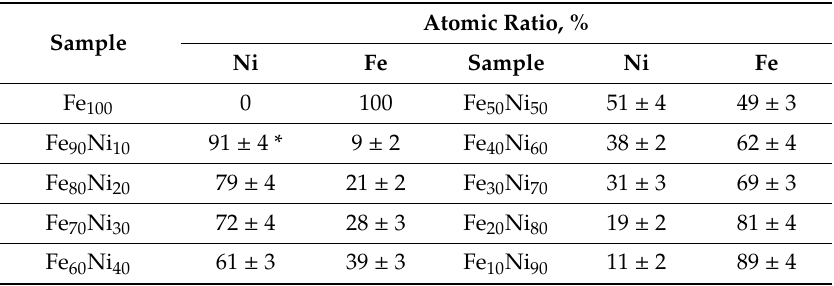
Table 1. The results of energy dispersive analysis of investigated nanostructures.